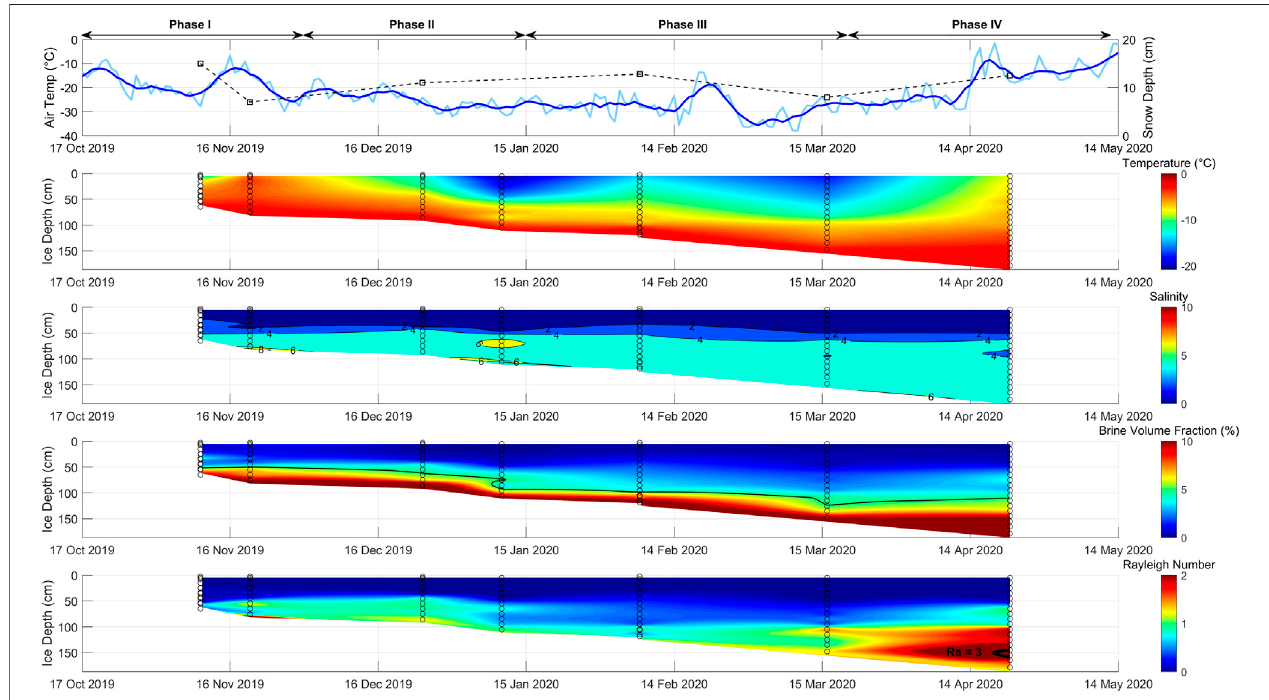
FIGURE 6 | The evolution of physical properties at the BGC2 second-year ice site. See Figure 3 caption for a description of common labels and annotations.